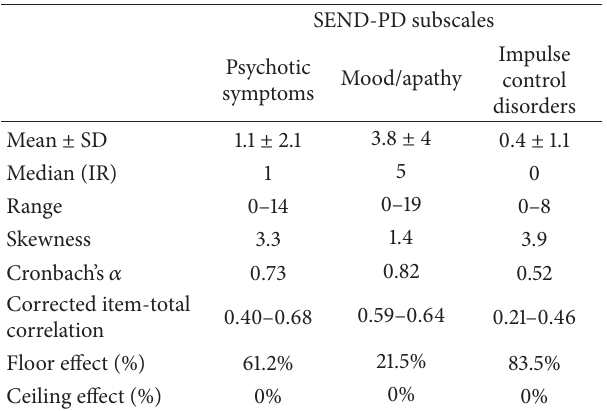
Table 2: Clinimetric properties of SEND-PD